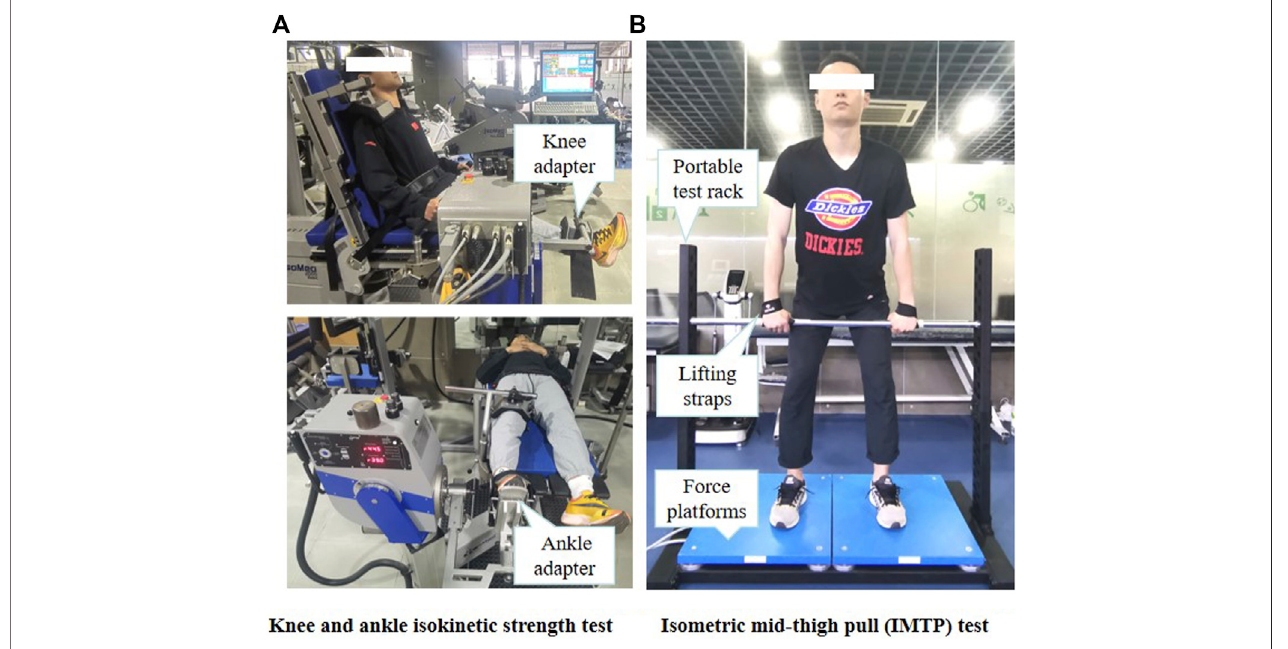
FIGURE 3 | Strength test. Interpretation of (A) knee and ankle isokinetic strength test (B) Isometric mid-thigh pull test. IMTP, isometric mid-thigh pull.